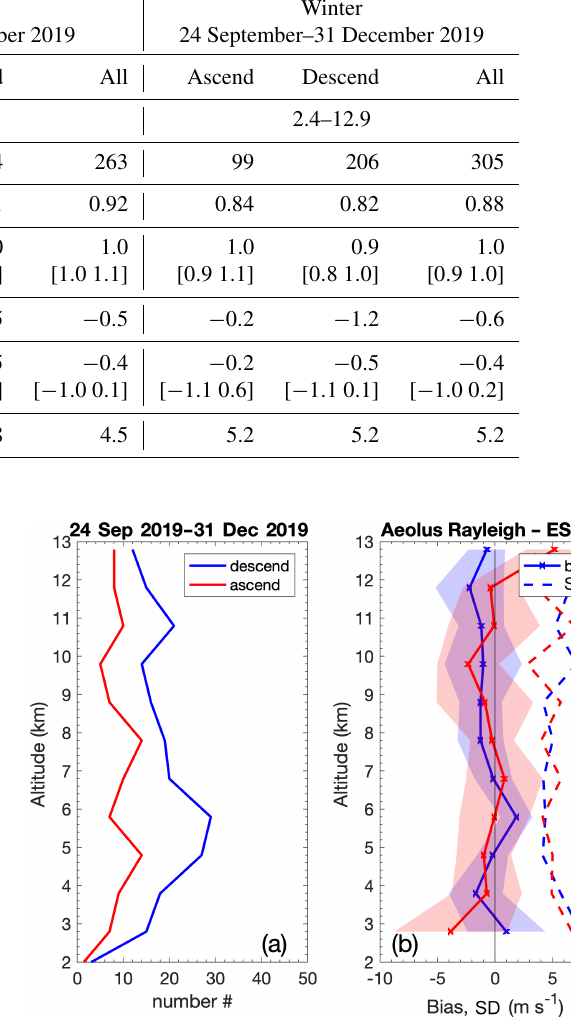
Figure 12. The same as Fig. 11 but for Aeolus Rayleigh